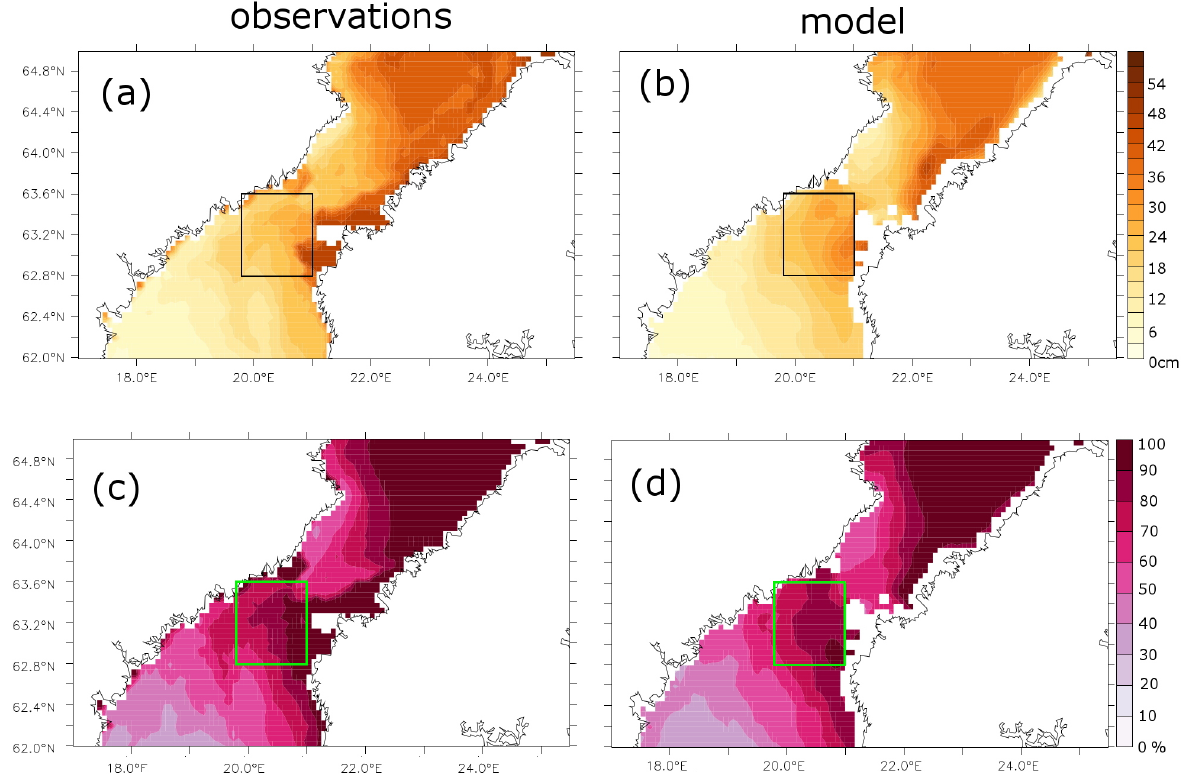
Figure 3. Mean forecasted and observed (a, b) level ice thickness and (c, d) ice concentrations during winter 2011 (JFMA). The squares mark the test region considered in this study. (a) and (c) were generated by using MyOcean